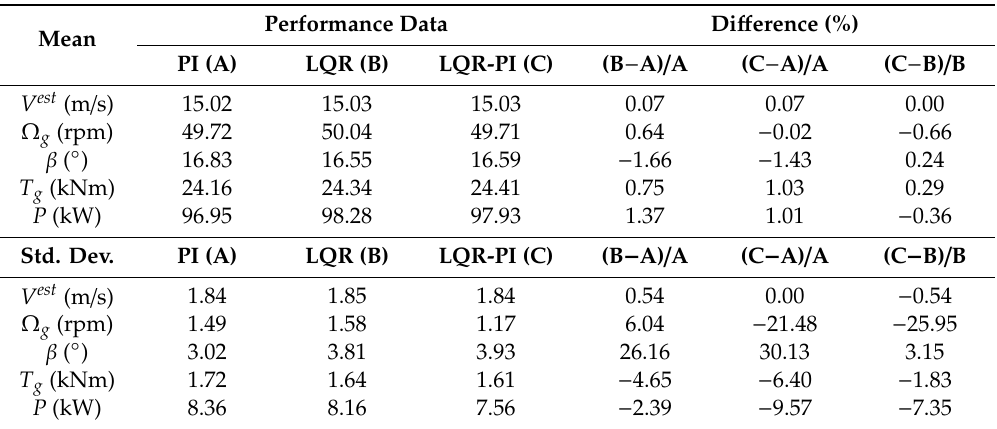
Table 5. Quantitative comparison of the performance data in the rated power region in the presence of